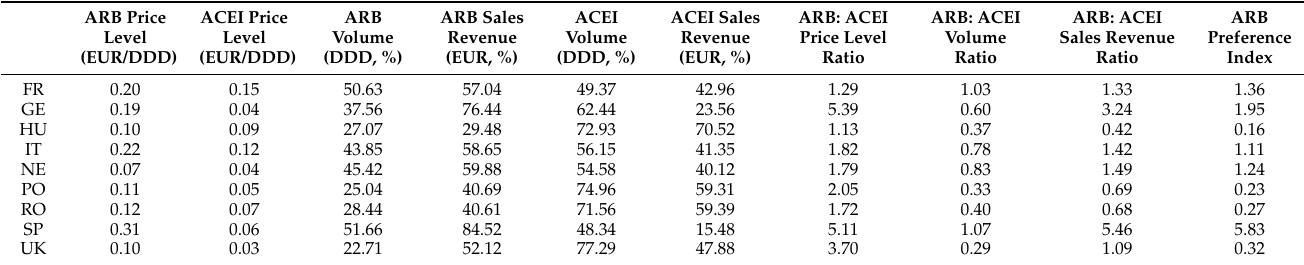
Table 3. Market features of ARBs and ACE inhibitors in 2016 considering adjusted volume of combination drugs and single-drug